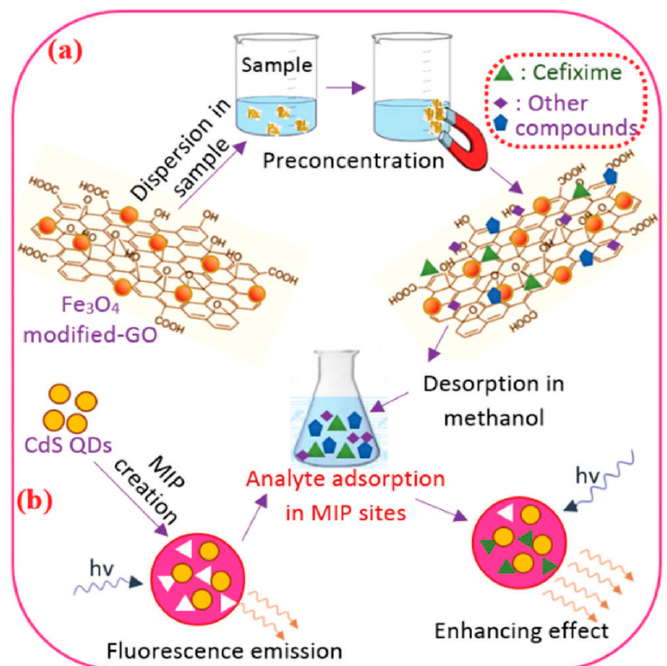
Figure 8. The preparation of FIPs based on CdS quantum dots for the determination of cefixime residues in urine: ( a ) the preconcentration of cefixime, ( b ) fluorometric determination using FIPs. Reprinted with permission from [96], copyright (2017) Royal Society of Chemistry.